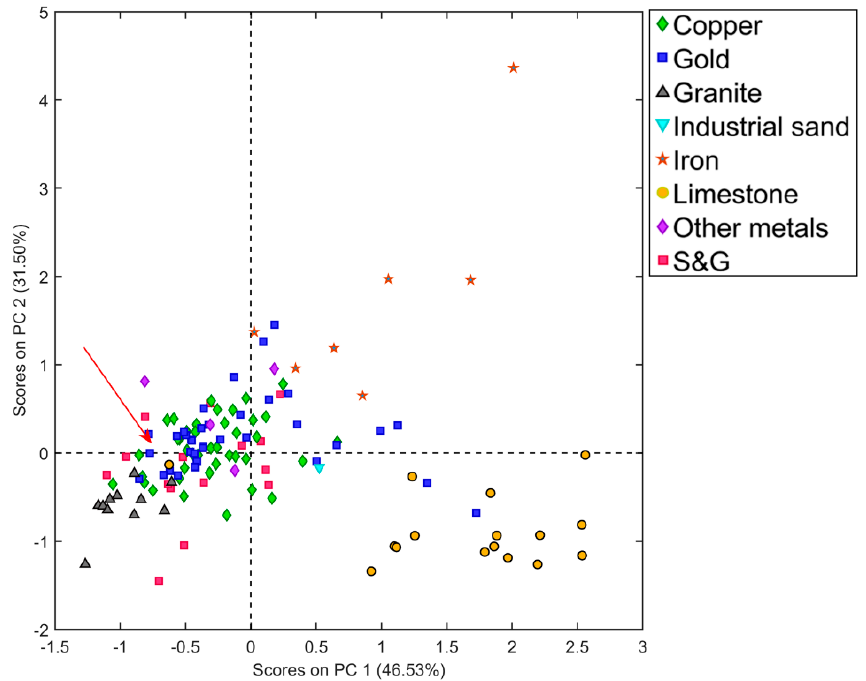
Figure 6. Samples scores on PC1 v. samples scores on PC2 from the PCA model for FTIR spectra of respirable mine dust. Arrow indicates unique limestone sample.